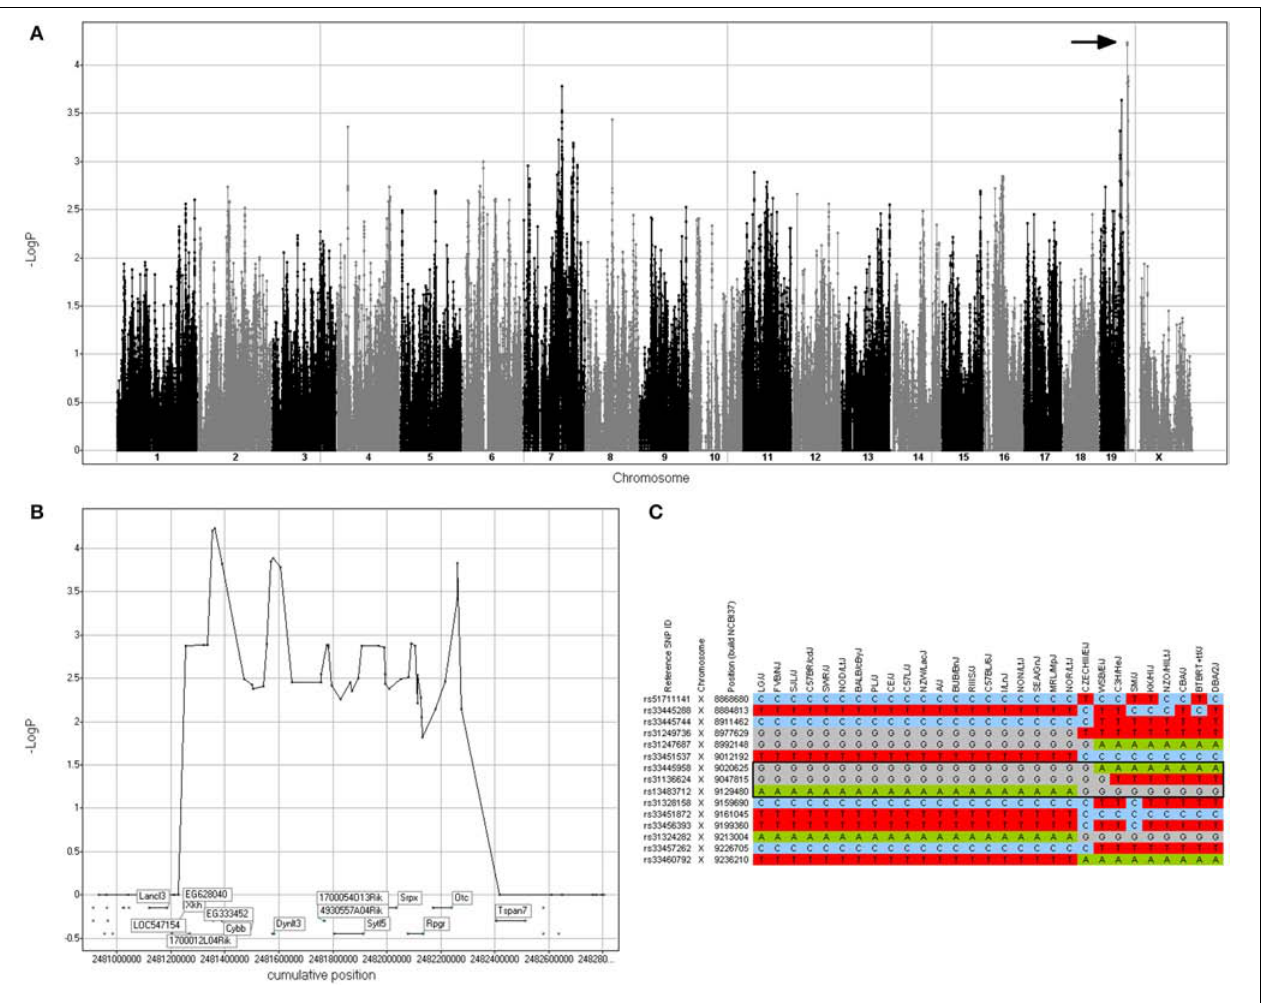
FIGURE 3 | Genomic region associated with rotenone cytotoxicity. (A) GWA Manhattan plot for cell loss after 72h of rotenone treatment. The region with the highest -log p -value that was selected for further analysis is indicated by the arrow. (B) Detail of the region in chromosome X annotated